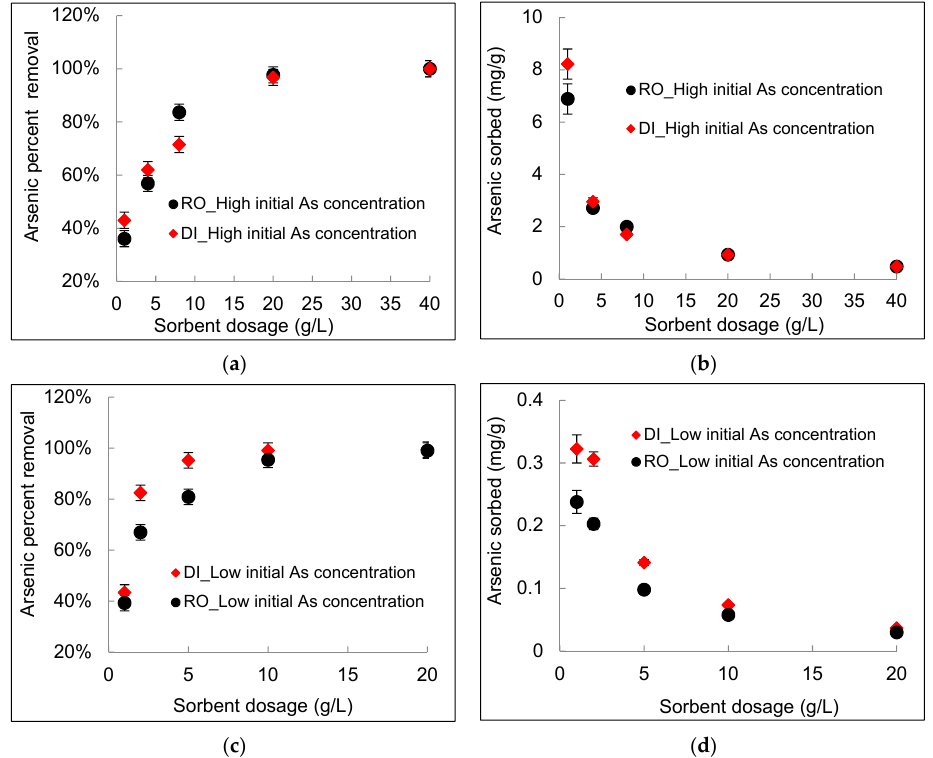
Figure 1. Effect of DWTS dosage on arsenic sorption at pH 7 and 23 °C. ( a ) Arsenic percent removal at high initial arsenic concentration (~20 mg/L); ( b ) Amount of arsenic sorbed at high initial arsenic concentration (~20 mg/L); ( c ) Arsenic percent removal at low initial arsenic concentration (~700 µg/L); ( d ) Amount of arsenic sorbed at low initial arsenic concentration (~700 µg/L). The error bars represent the standard deviation of duplicate or triplicate testing results.